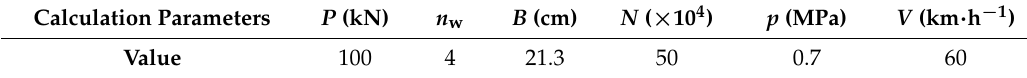
Table 12. Calculation parameters of rutting model.